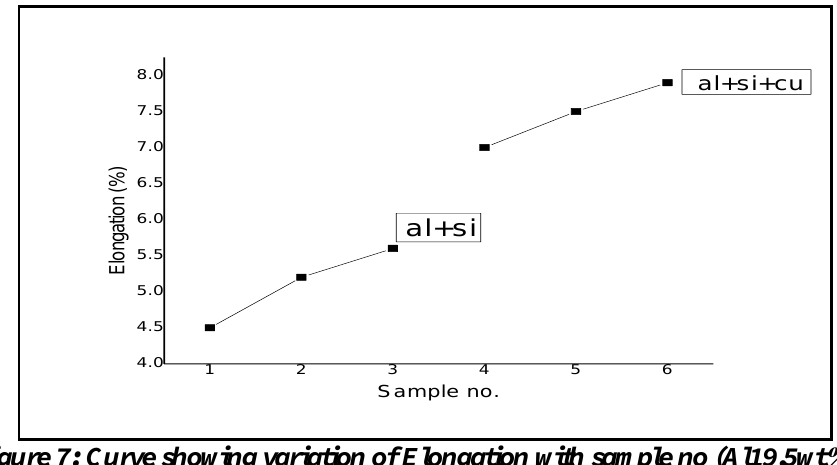
Figure 7: Curve showing variation of Elongation with sample no (Al19.5wt % Si, Al21wt % Si, Al22.5wt % Si, Al18wt % Si+1.5wt % Cu, Al19.5wt % Si +1.5wt % Cu, Al21wt % Si +1.5wt % Cu).